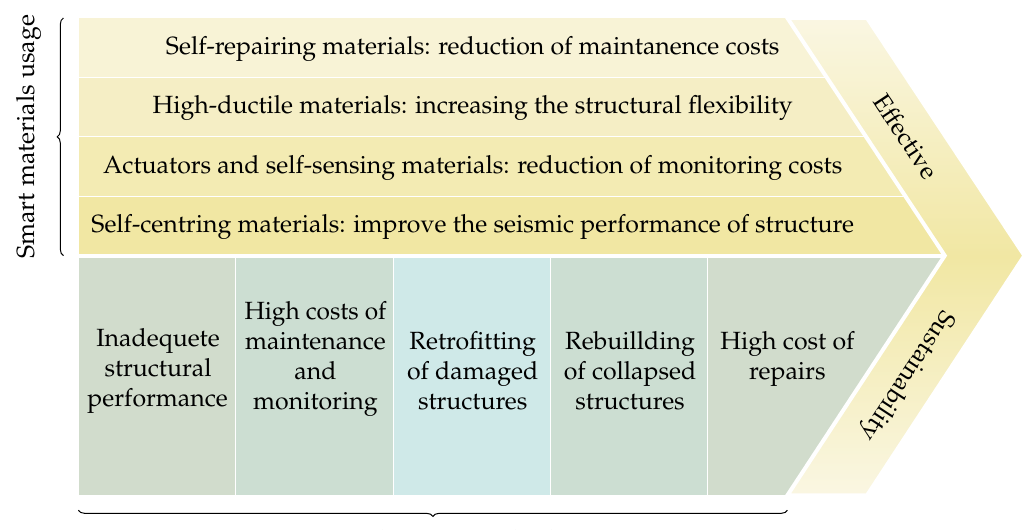
Figure 4. Several advantages of smart materials in the fourth stage (utilising) of a structure leading to an effective sustainable